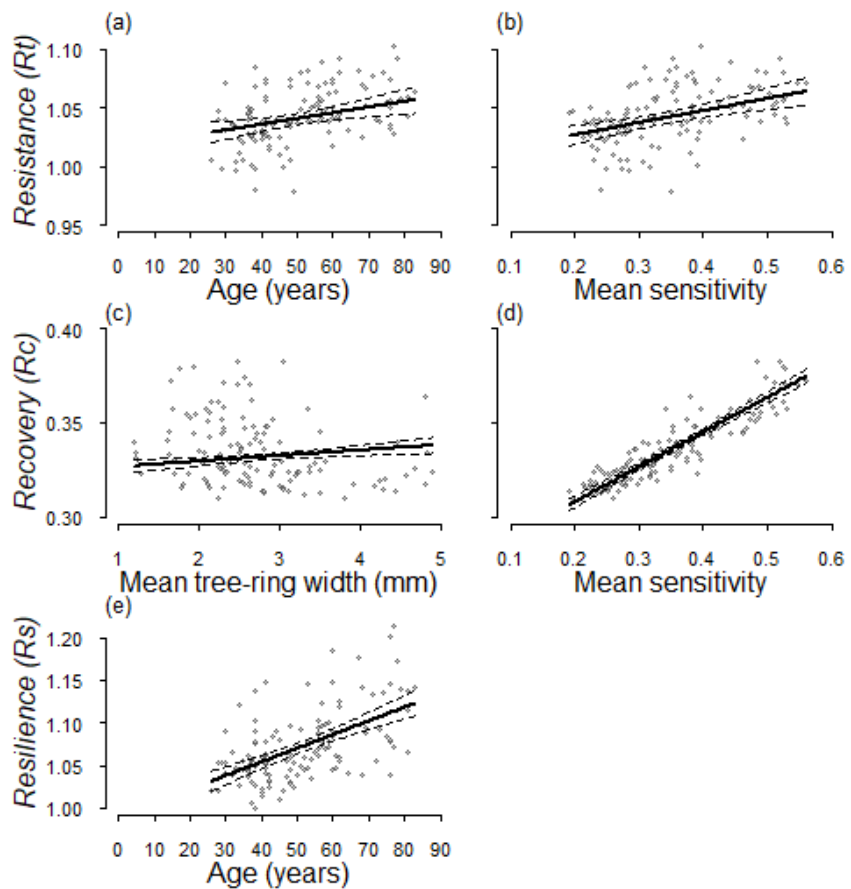
Figure 6. Effects of the fixed effects on the resistance ( a , b ), recovery ( c , d ) and resilience ( e ) components according to the linear mixed-effect models. The grey points indicate the values observed for each individual in the studied populations ( n = 130 trees) and the solid line indicates the effect of each fixed effect on the resilinece components (dashed lines represent the upper and lower confidence